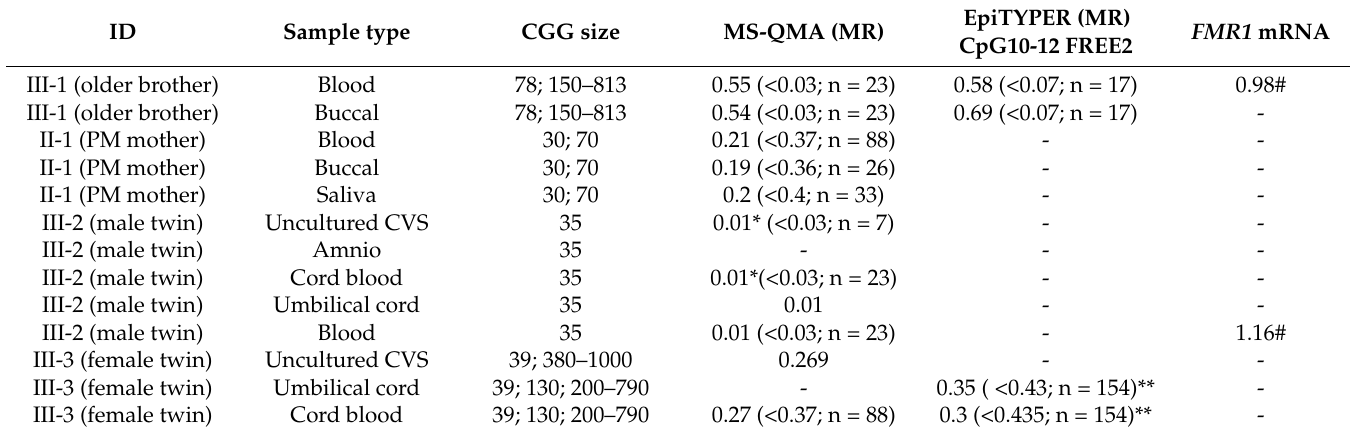
Table 1. Summary of FMR1 testing performed in prenatal and postnatal